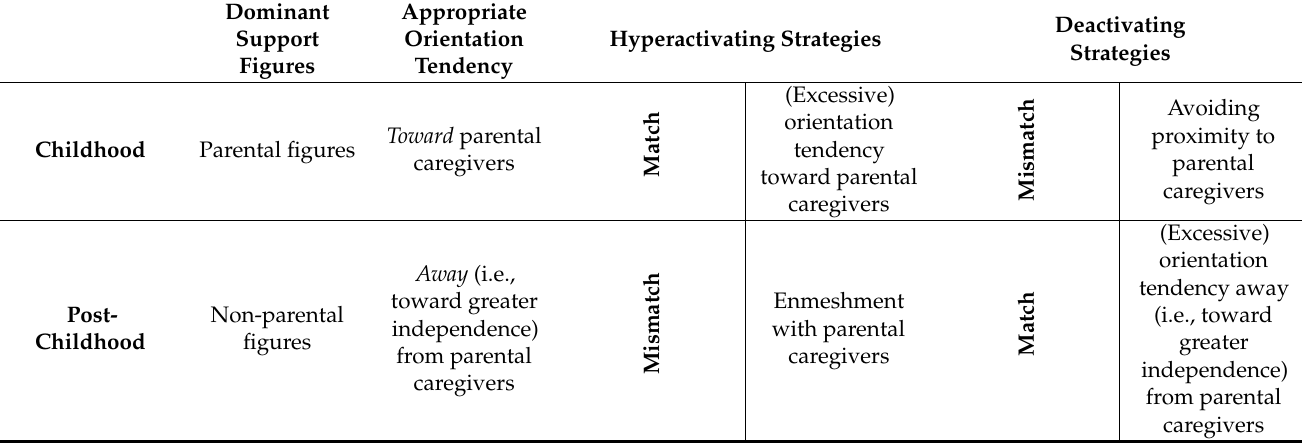
Table 2. The mis/match between insecure attachment strategies and the orientation tendencies toward or away from caregivers by developmental